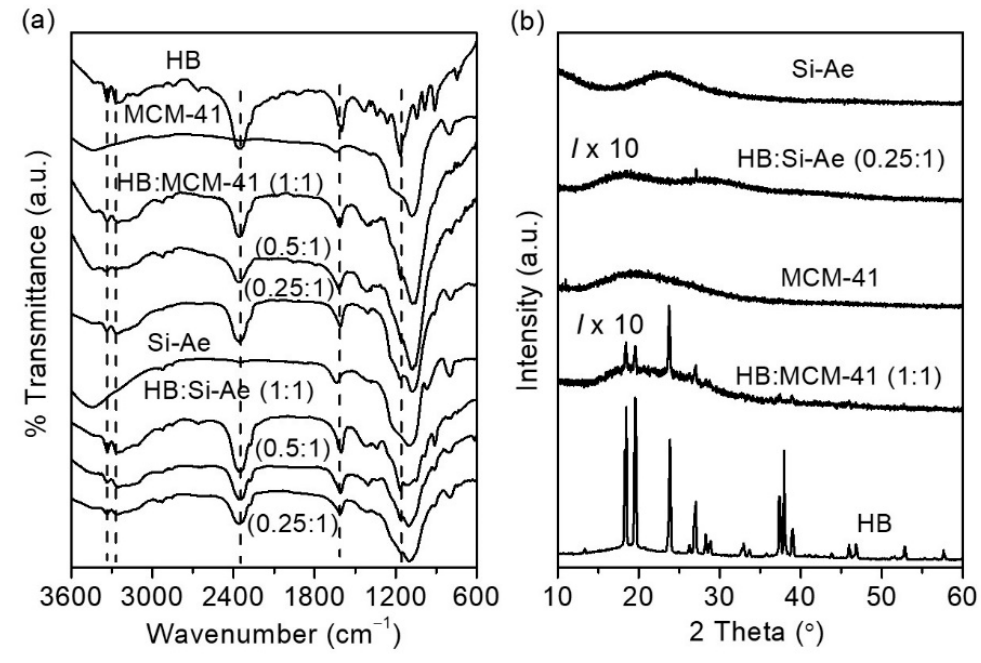
Figure 2. ( a ) FTIR and ( b ) XRD characterizations of HB, MCM-41, silica aerogel, HB/MCM-41 and HB/Si-Ae at various HB loading.